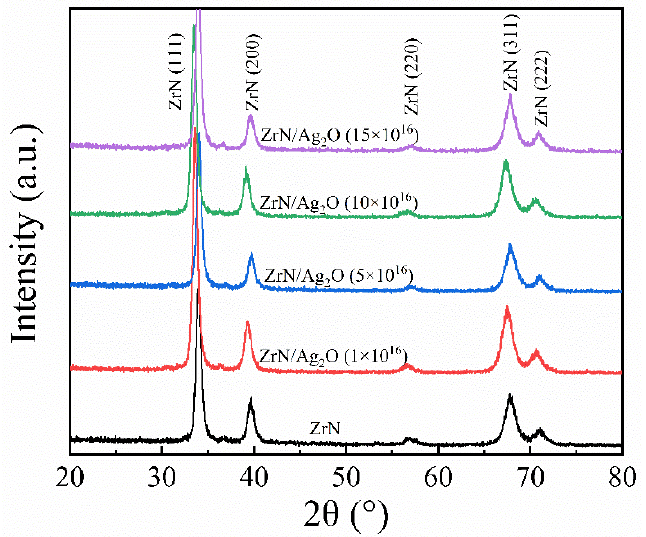
Figure 3. X-ray diffraction pattern of the separate ZrN coating and different doses of ZrN/Ag 2 O gradient composite